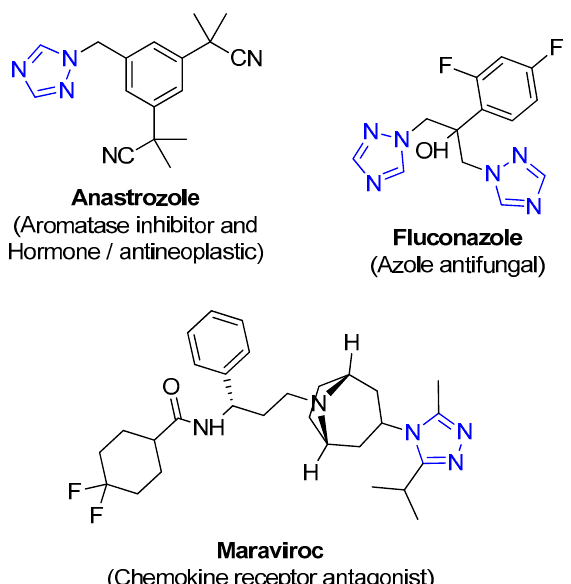
Figure 9. Drugs containing a triazole ring.